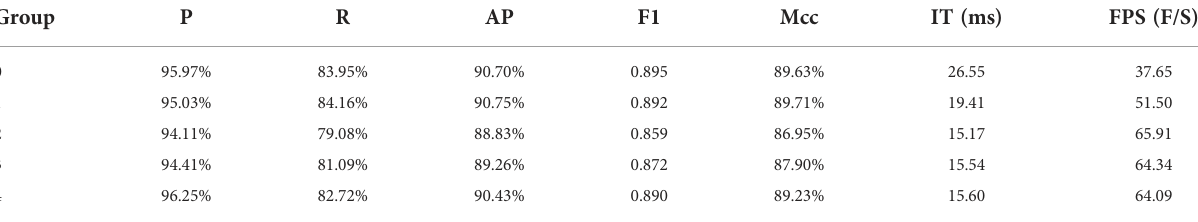
TABLE 5 Statistics of ablation